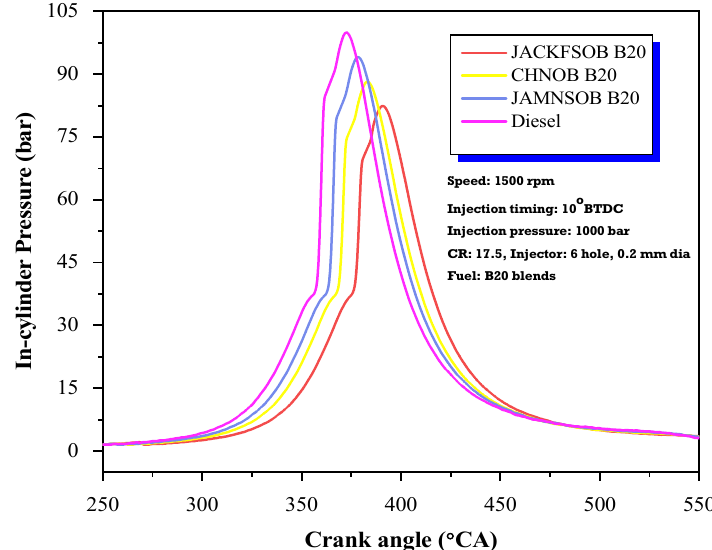
Figure 14. Variation of CP vs. CA.